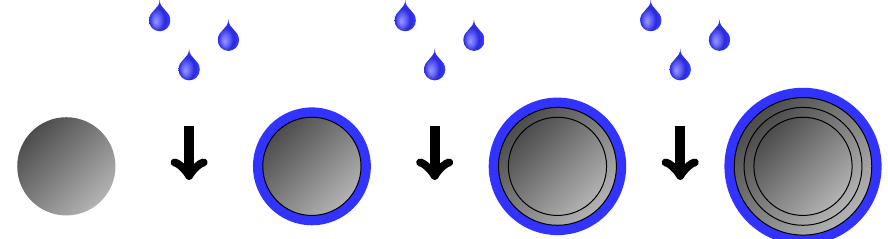
Figure 1. Layering growth subprocess resulting in an onion-like particle structure.